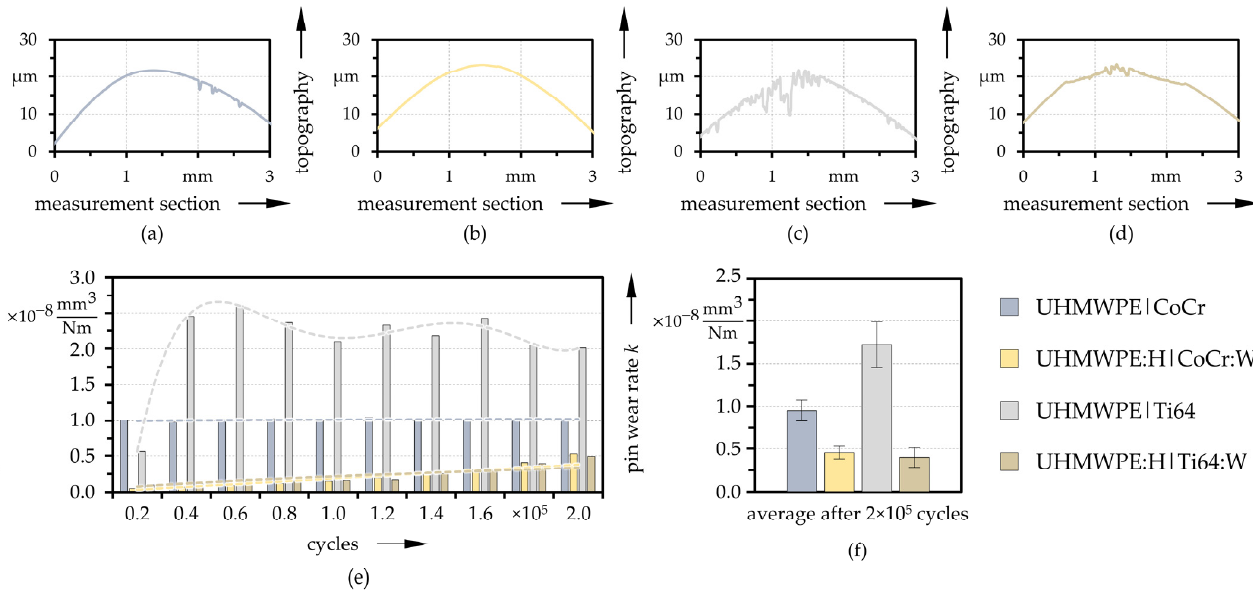
Figure 7. Exemplary cross sections of the pins ( a – d ) as well as evolution of the pin wear coefficients with trend-lines ( n = 1) after each testing interval ( e ) and averaged values ( n = 3) after the entire test duration ( f ) for the reference and coated pairings.